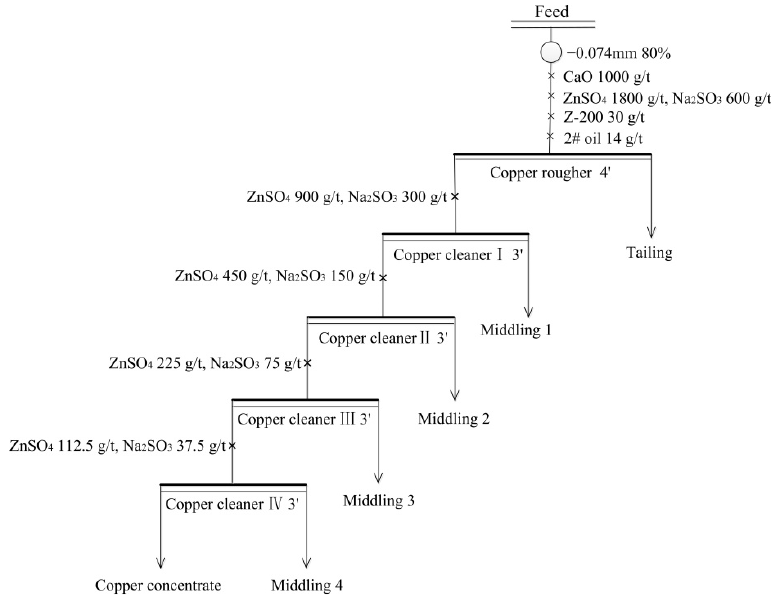
Figure 11. The experimental flow charts of the effect of the number of cleaning cycles in copper flotation.